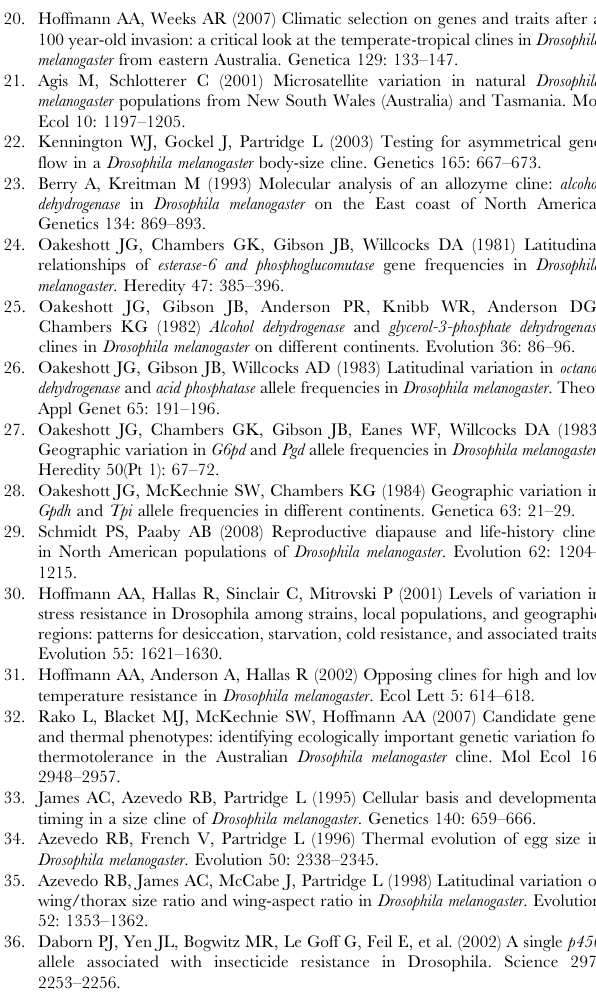
Table S4 D. melanogaster isofemale strains used in this study.